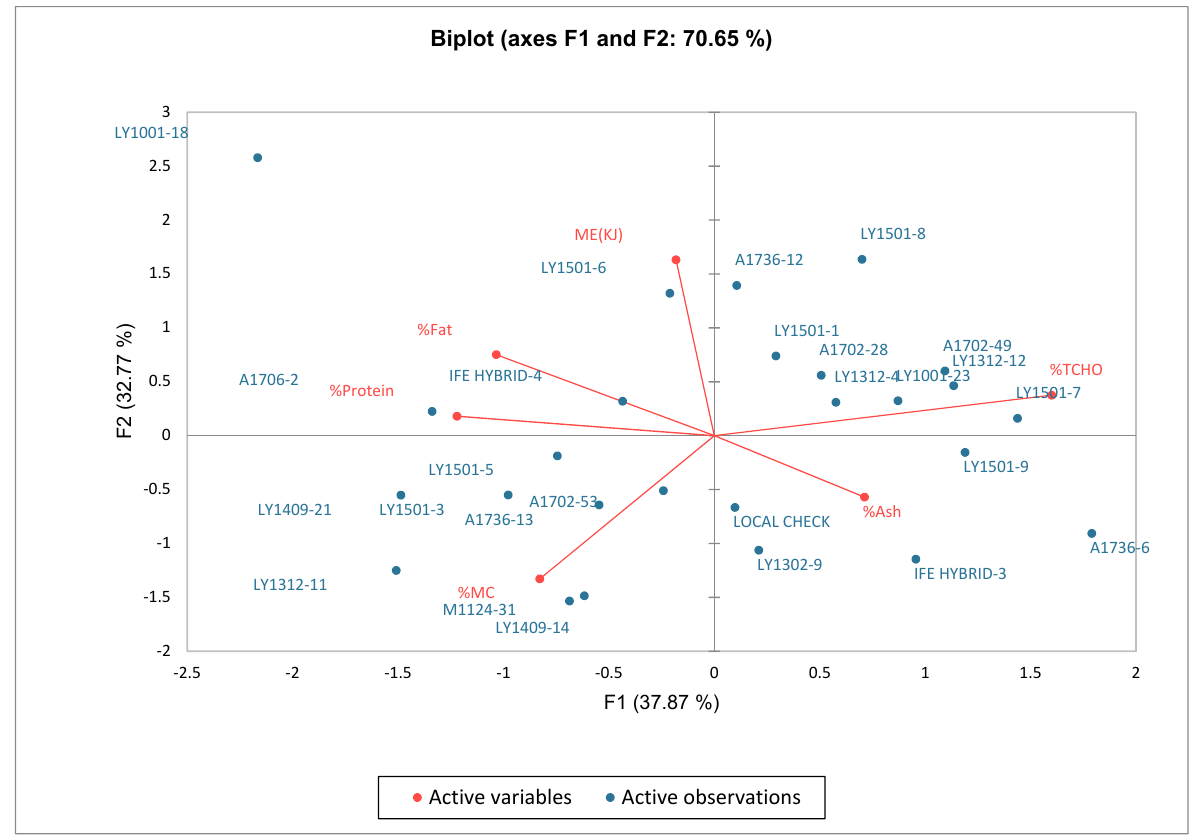
Figure 1. Principal component analysis of maize genotypes.